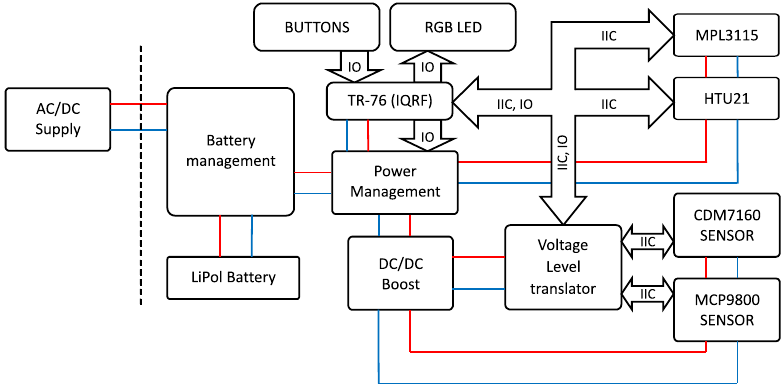
Figure 2. Internal structure of the RMCD